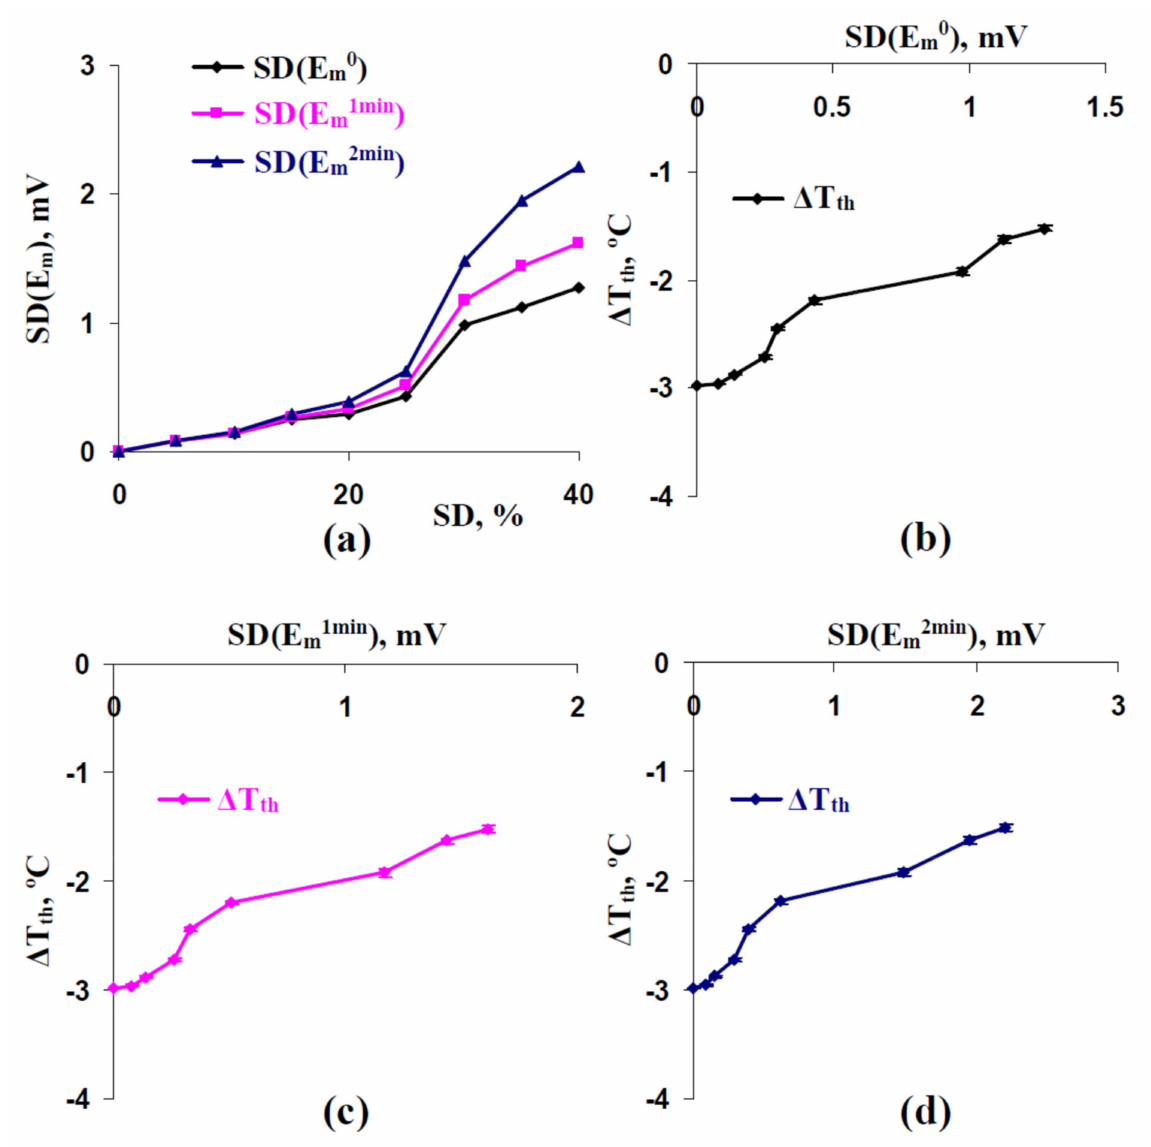
Figure 9. ( a ) Dependences of standard deviations of the membrane potential (SD(E m )) before the cooling initiation (SD(E m0 )), at 1 min after initiations of the cooling with a 0.5 ◦ C min − 1 rate (SD(E m1 min )), and at 2 min after initiations of the cooling with a 0.5 ◦ C min − 1 rate (SD(E m2 min )) on standard deviation of initial H + -ATP-ase activity in cells (SD). ( b ) Dependence of temperature thresholds of the first action potential ( ∆ T th ) on SD(E m0 ). ( c ) Dependences of ∆ T th on SD(E m1 min ). ( d ) Dependences of ∆ T th on SD(E m2 min ). SD(E m0 ), SD(E m1 min ), and SD(E m2 min ) were calculated on the basis of 25 repeated simulations. Averaged temperature thresholds ( ∆ T th ) from Figure 4 were